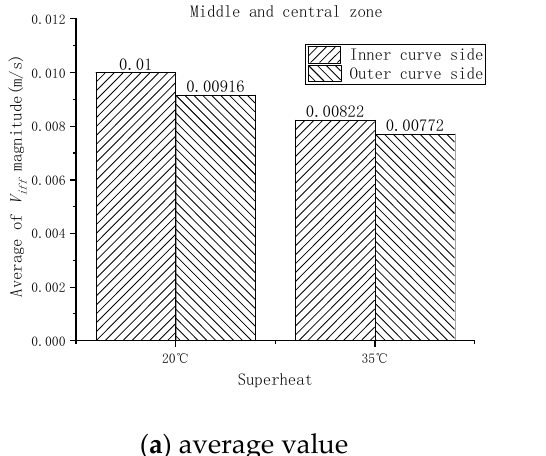
Figure 17. Average value and standard deviation of interdendritic fluid flow velocity V if f magnitude of middle and central zones in the inner curve side and the outer curve side under 20 °C and 35 °C : ( a ) average value, ( b ) standard deviation.